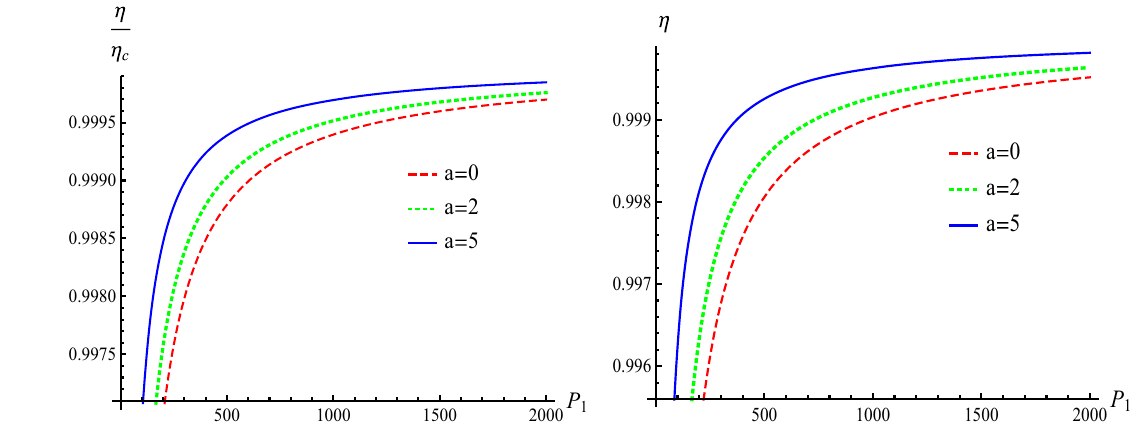
Fig. 6 The two figures above are plotted at three different fixed normalization factors a , here we take P 2 = 4 , S 1 = 1 , S 2 = 4 , Q = 1 and state parameter ω q = − 1